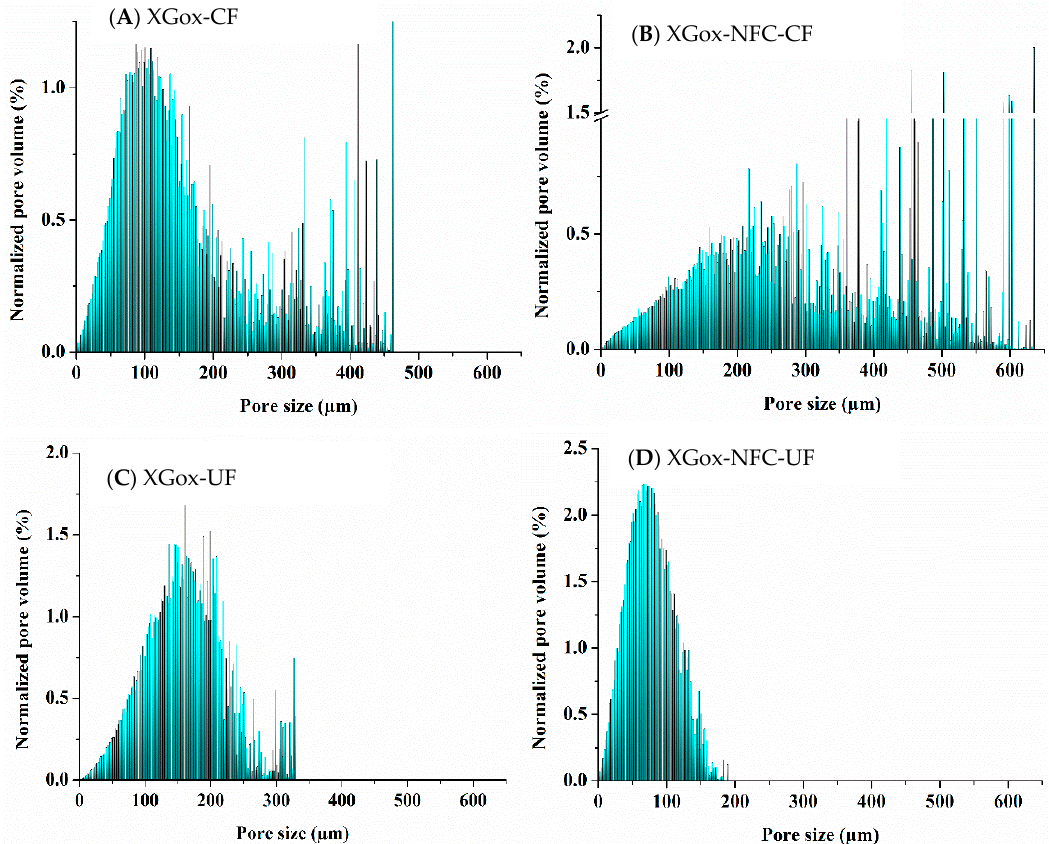
Figure 8. Volume-weighted pore-size distribution of ( A ) XGox and ( B ) XGox reinforced with NFC using the conventional freezing (CF) method. Volume-weighted pore-size distribution of ( C ) XGox and ( D ) XGox reinforced with NFC prepared by the unidirectional freezing (UF) method.